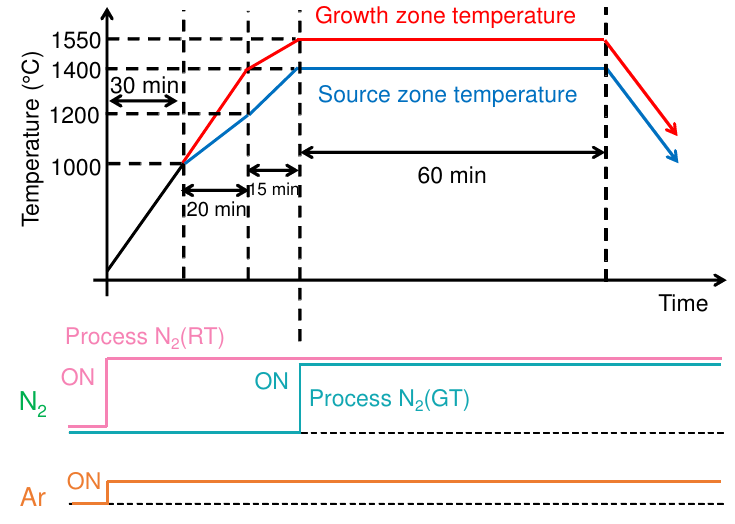
Figure 2. Temperature profiles and gas flow sequences.